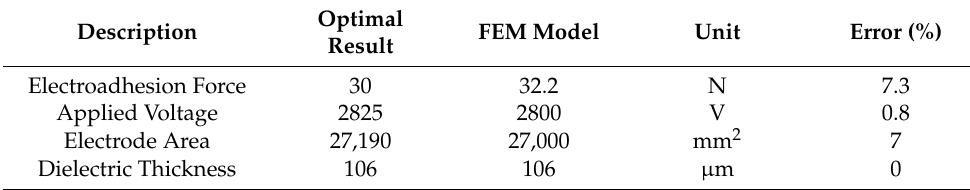
Table 8. Optimal design and analysis verification: